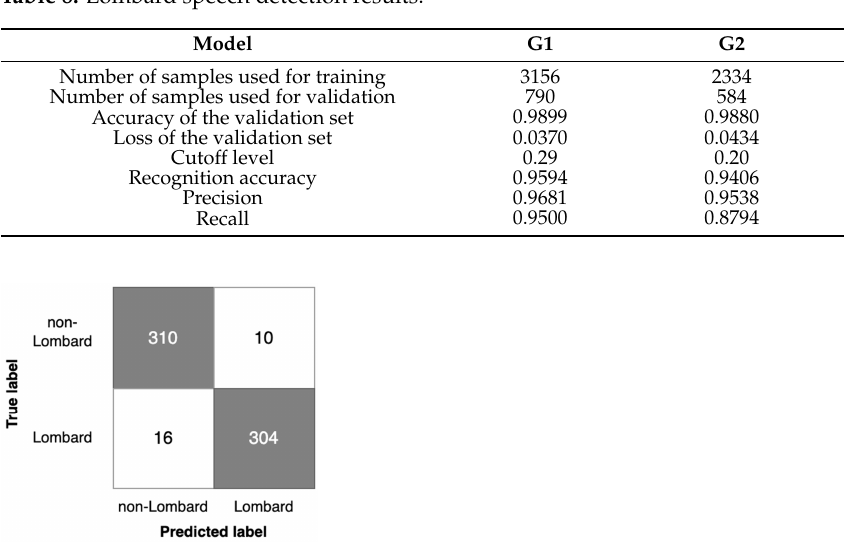
Figure 8. Confusion matrix for the G1 model.